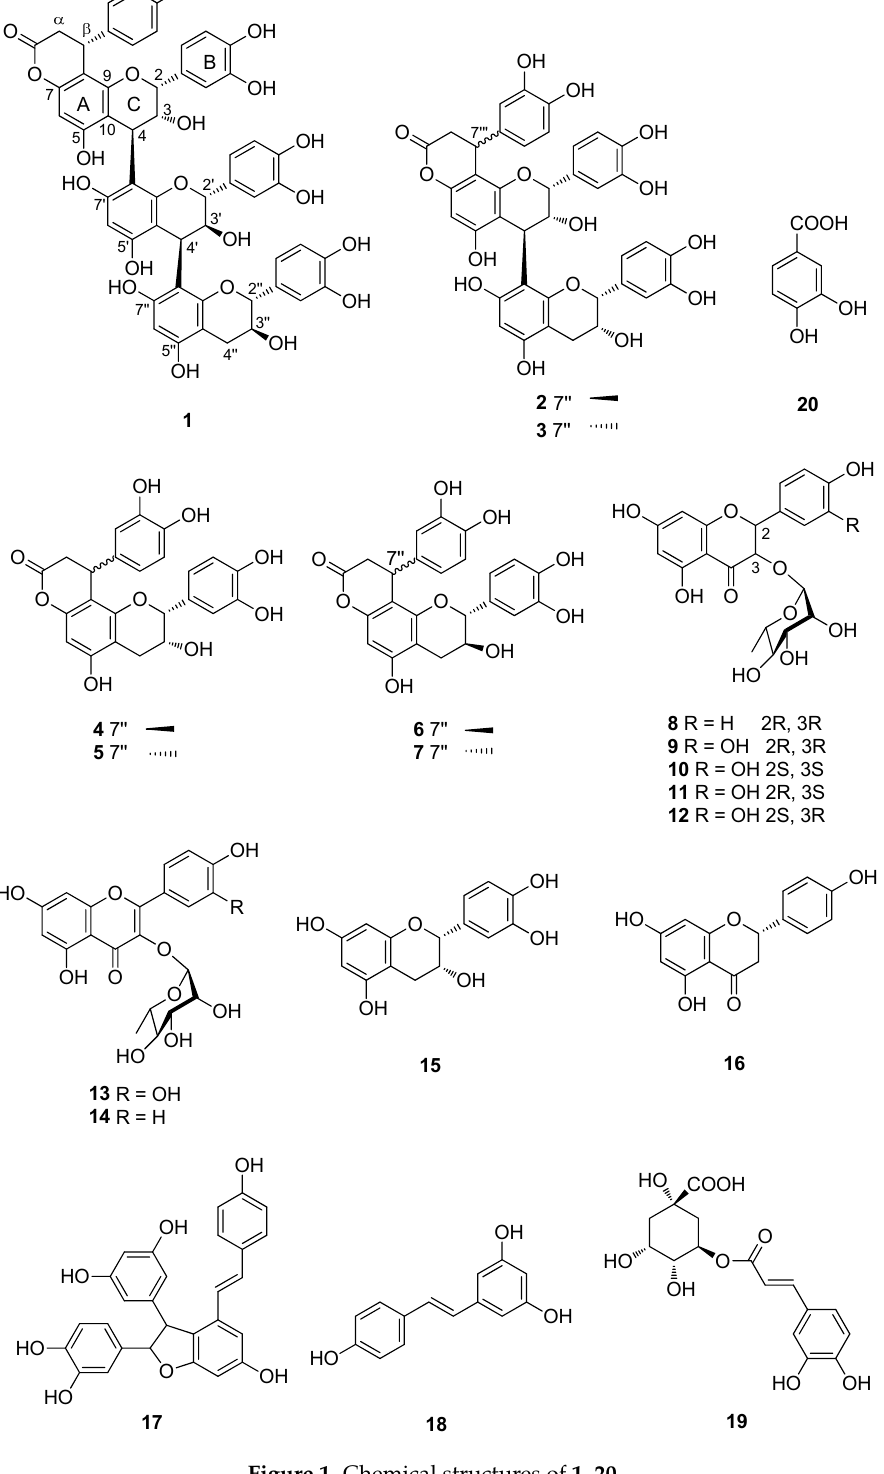
Figure 1. Chemical structures of 1 – 20 .